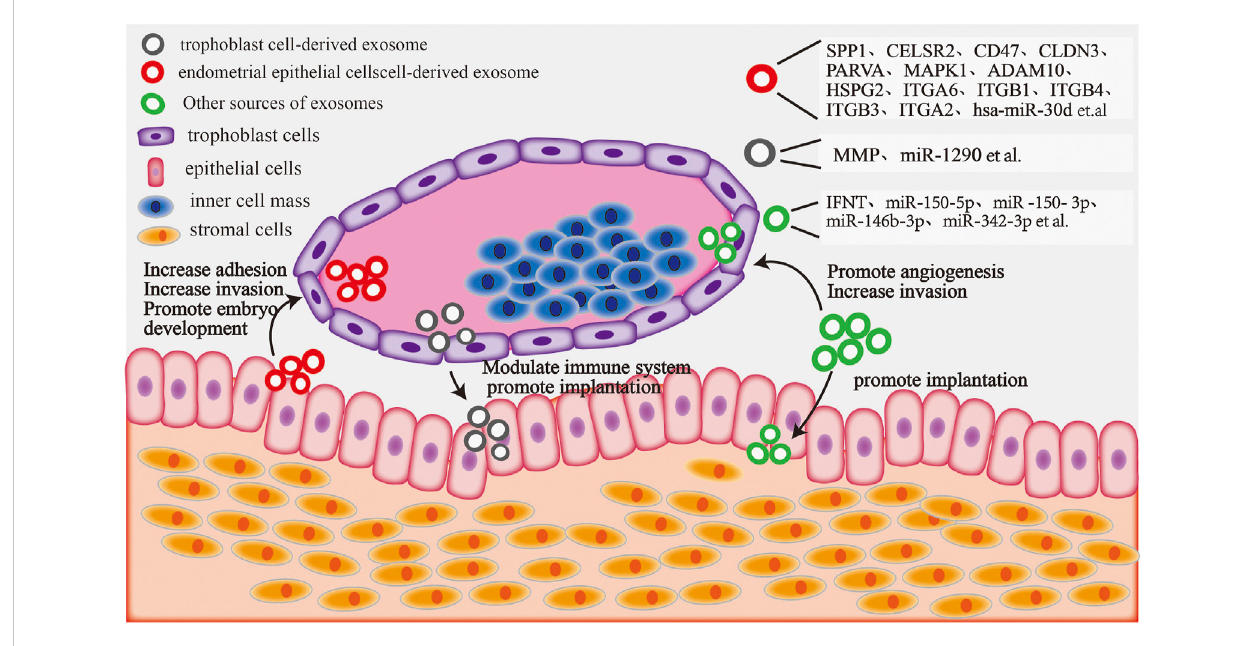
FIGURE 3 Theblastocystandendometriuminteractwithexosomecomponents:endometrialepithelialcell-derivedexosomalproteinsandmiRNAscantarget trophoblast cells, increasing their adhesion and invasion and promoting embryo development. Embryonic trophoblast cell-derived exosomal proteins and miRNAs can regulate the maternal immune system and increase embryo attachment by targeting endometrial epithelial cells. Moreover, exosomal components derived from other sources (including plasma, serum, and follicular fl uid) can target trophoblast cells to facilitate invasion and angiogenesis, whereas others can target endometrial epithelial cells to promote embryonic